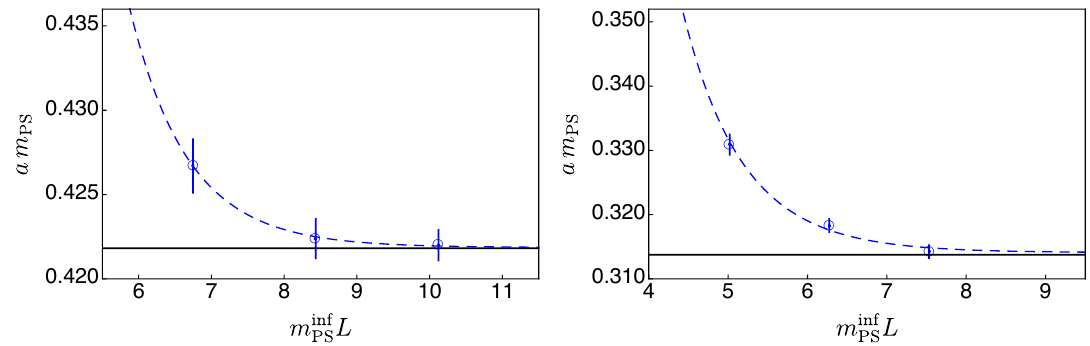
Figure 5. Volume dependence of the pseudoscalar masses, as in table 4. Lattice parameters are ( (cid:12); m 0 ) = (7 : 2 ; (cid:0) 0 : 77) in the left panel and (7 : 2 ; (cid:0) 0 : 79) in the right panel. The (blue) dashed and (black) solid lines denote the (cid:12)t results and the extrapolated values in the in(cid:12)nite volume limit,